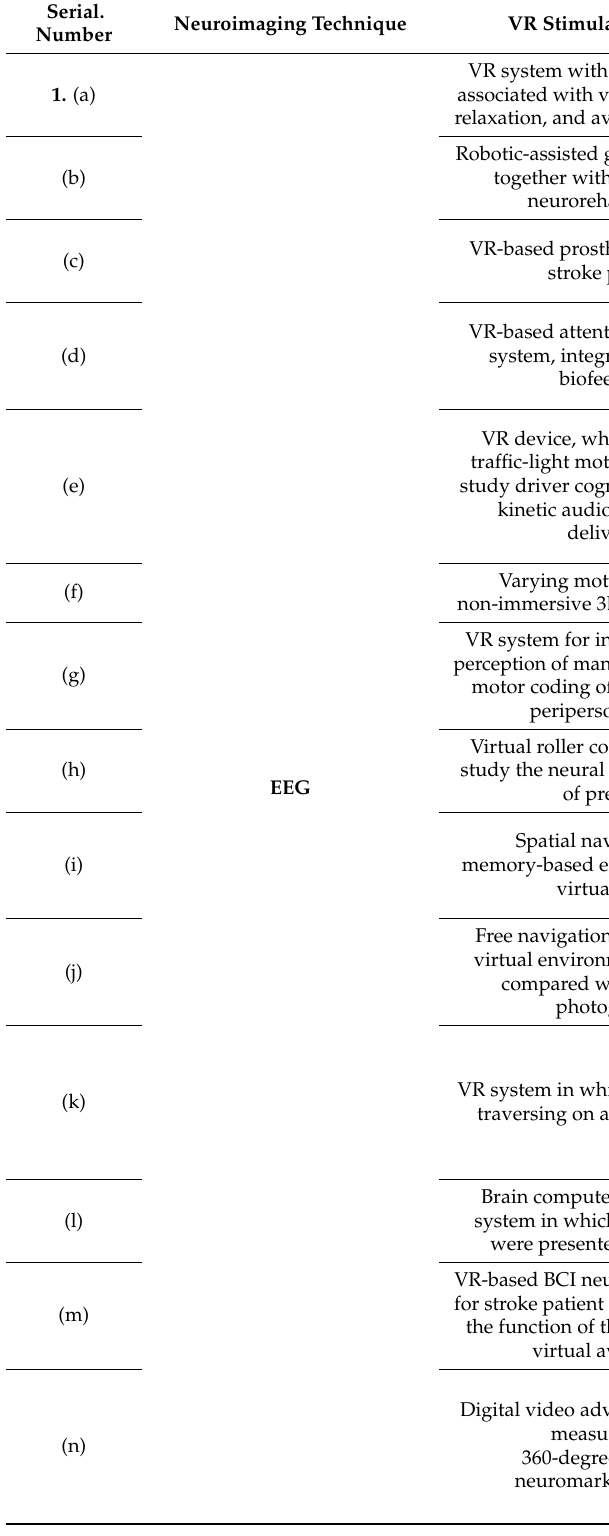
Table 1. An overview of synergistic relation and applicability of VR systems in neuroimaging research. Serial.